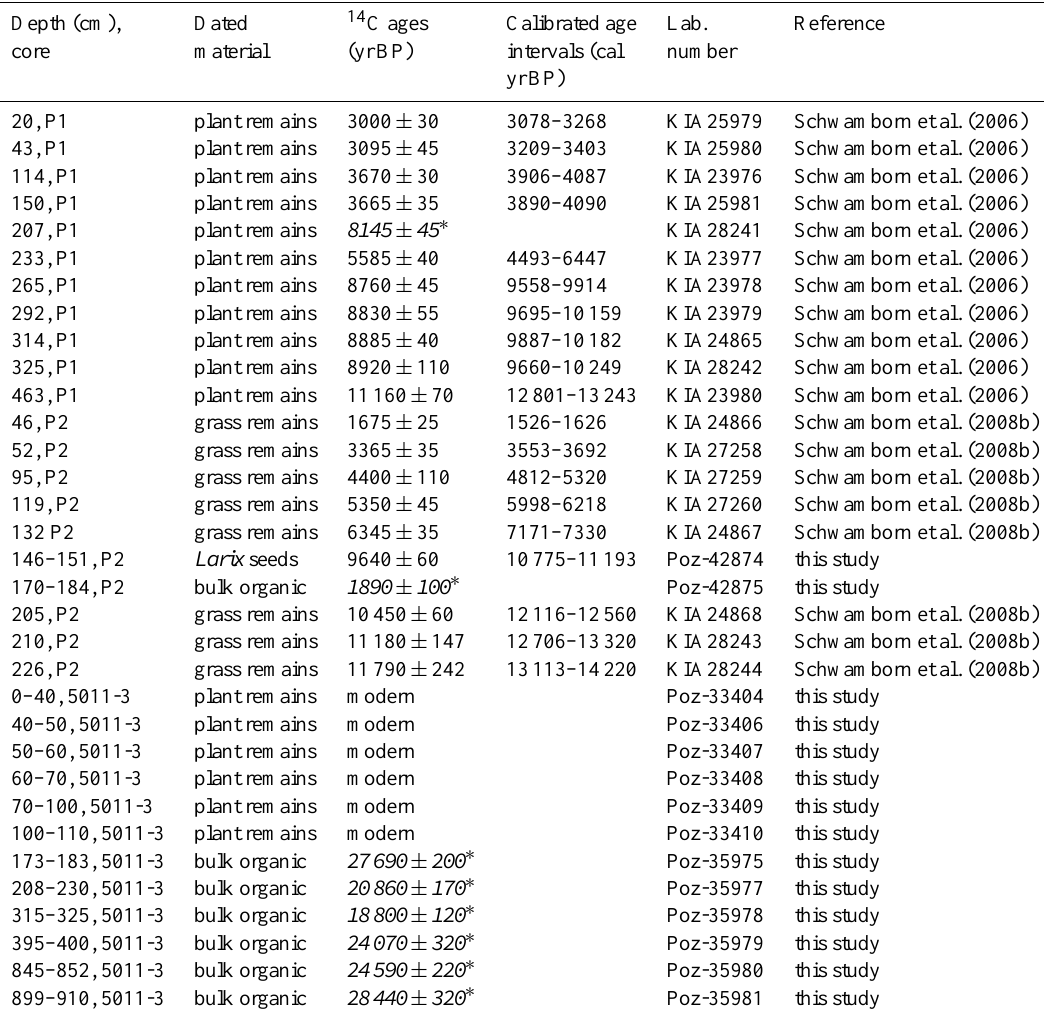
Table 1. Radiocarbon and calibrated ages enclose the two-sigma range of highest probability. The ages have been calibrated using CALIB Rev 6.1.0. (Reimer et al., 2009). The obviously inversed ages were rejected dates and marked with ∗ . Depth